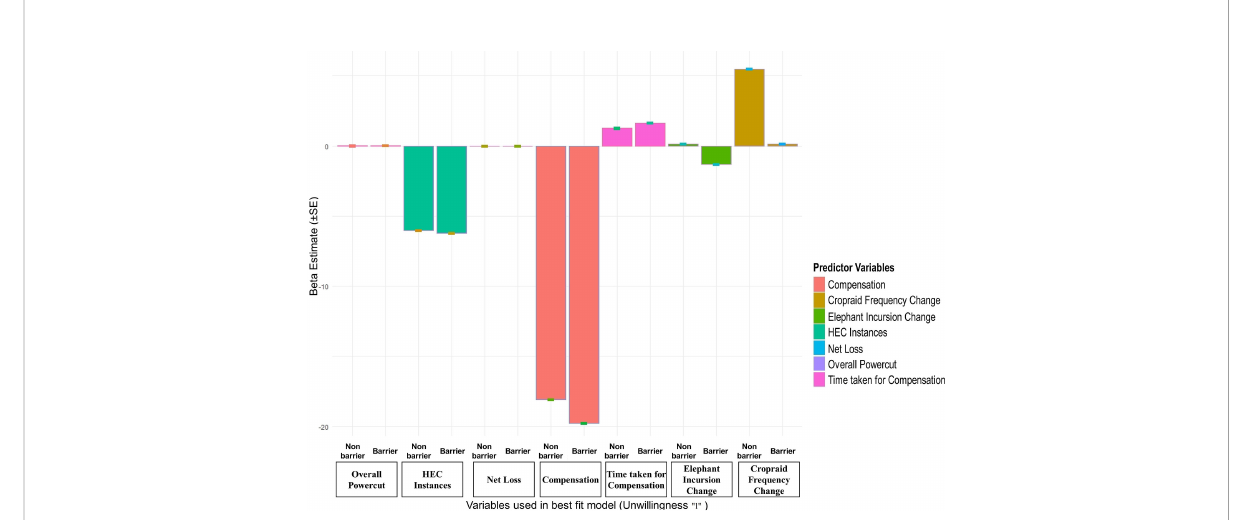
FIGURE 8 Comparisons of the relationship between beta estimates and different variables from least AICc model for category “ 1 ” (unwilling to pay for maintenance of barriers) for both barrier and non-barrier